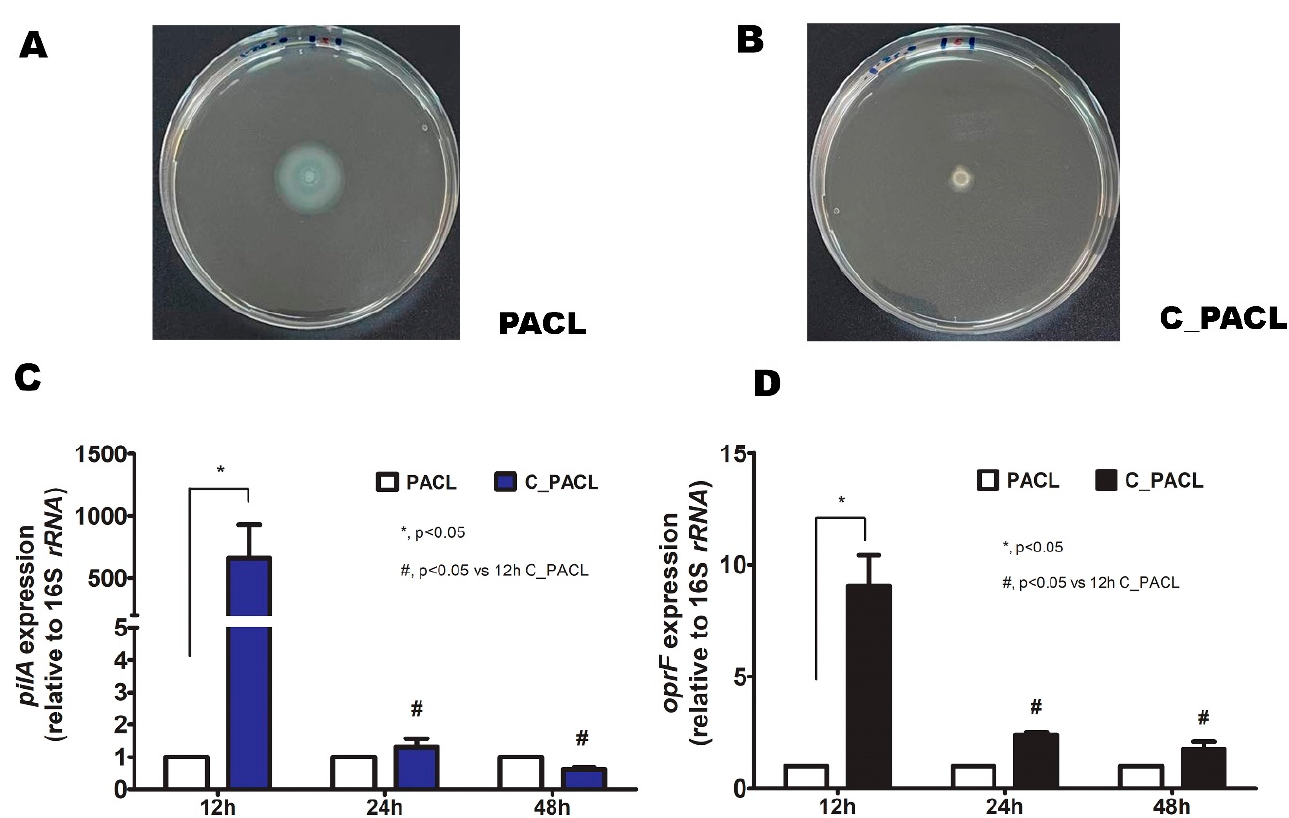
Figure 6. The characteristics of P. aeruginosa parent strain (PACL) and Chlorhexidine (CHG)-treated strain (C_PACL) biofilm as indicated by the reduction of motility (swarming motility) using 0.5% agar in Luria Broth (LB) agar medium by spotting the overnight culture of bacteria at the center of the plates after 18 h incubation at 37 ◦ C ( A , B ) with the expressions of pilA ( C ) and oprF ( D ) (encoding for type-4 pili biosynthesis and OprF proteins of bacterial appendages, respectively) are demonstrated (the experiments were performed in independent triplicate). Mean values of the relative mRNA expression were plotted with error bars representing the SEM. The p -values were calculated using one-way ANOVA followed by Tukey’s analysis (*, p < 0.05 and # , p < 0.05 considered statistically significant).